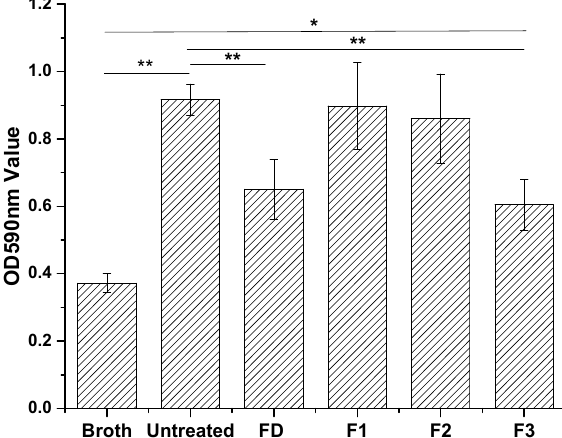
Figure 5. Optical density of the eluted acetic acid from the crystal violet stained metal samples after incubation with S. aureus demonstrating the antibiofilm ability of untreated as well as DA- and cyclotide-treated metal surfaces. Metal disk samples treated with DA, P1, P2, and P3 were denoted as FD, F1, F2, and F3, respectively. ANOVA was used to compare groups (* p < 0.05; ** p < 0.01, n = 4). Error bars indicate the standard deviation of the four independent measurements.